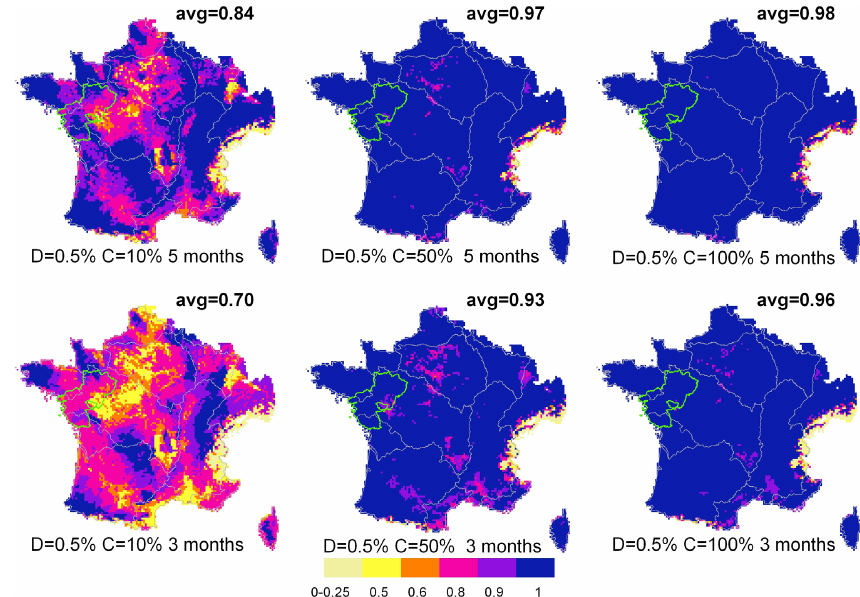
Figure 9. Mean maximum storage fraction of the dams over the 30-year period for 5-month (top) and 3-month (bottom) filling periods. The Pays de la Loire region and the Layon Basin are outlined in green.